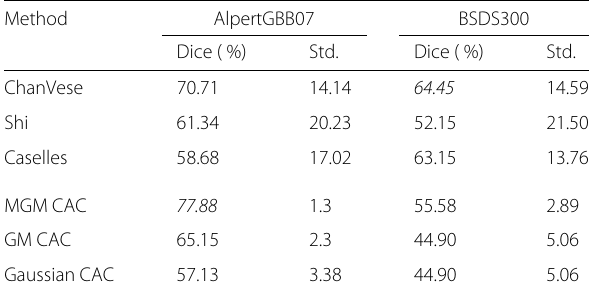
Italic means best